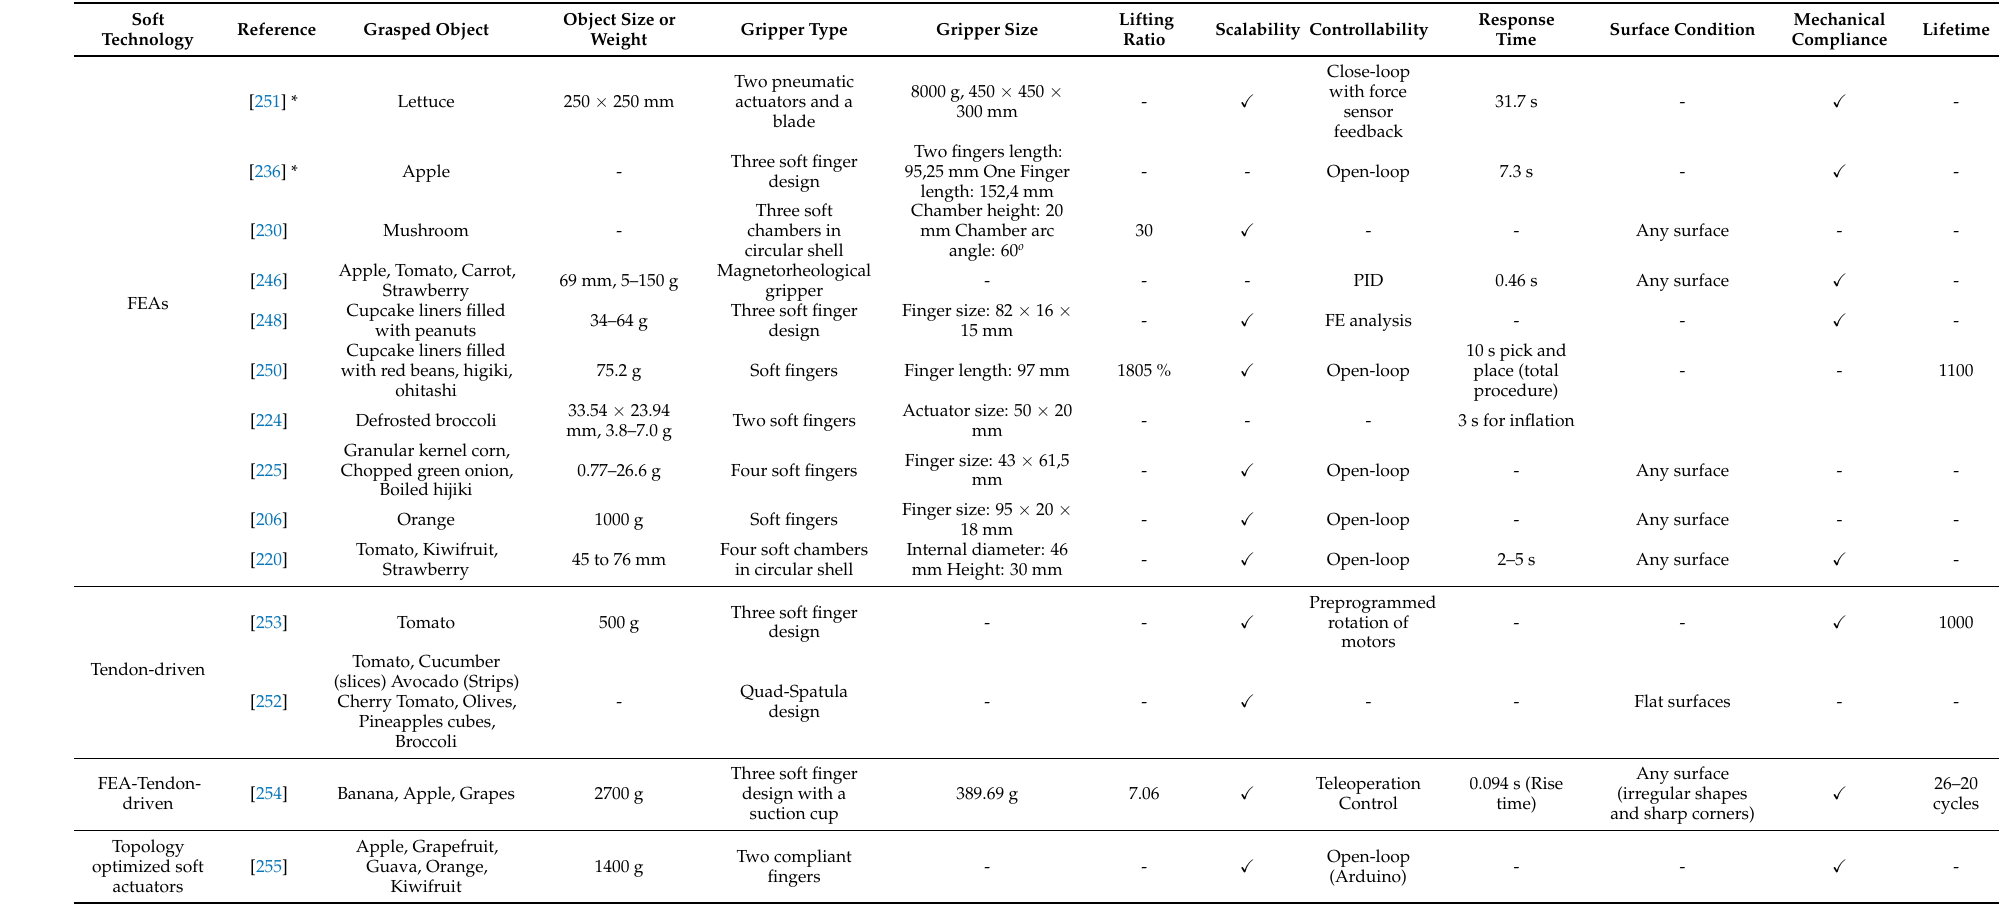
Table 4. Literature review of food soft